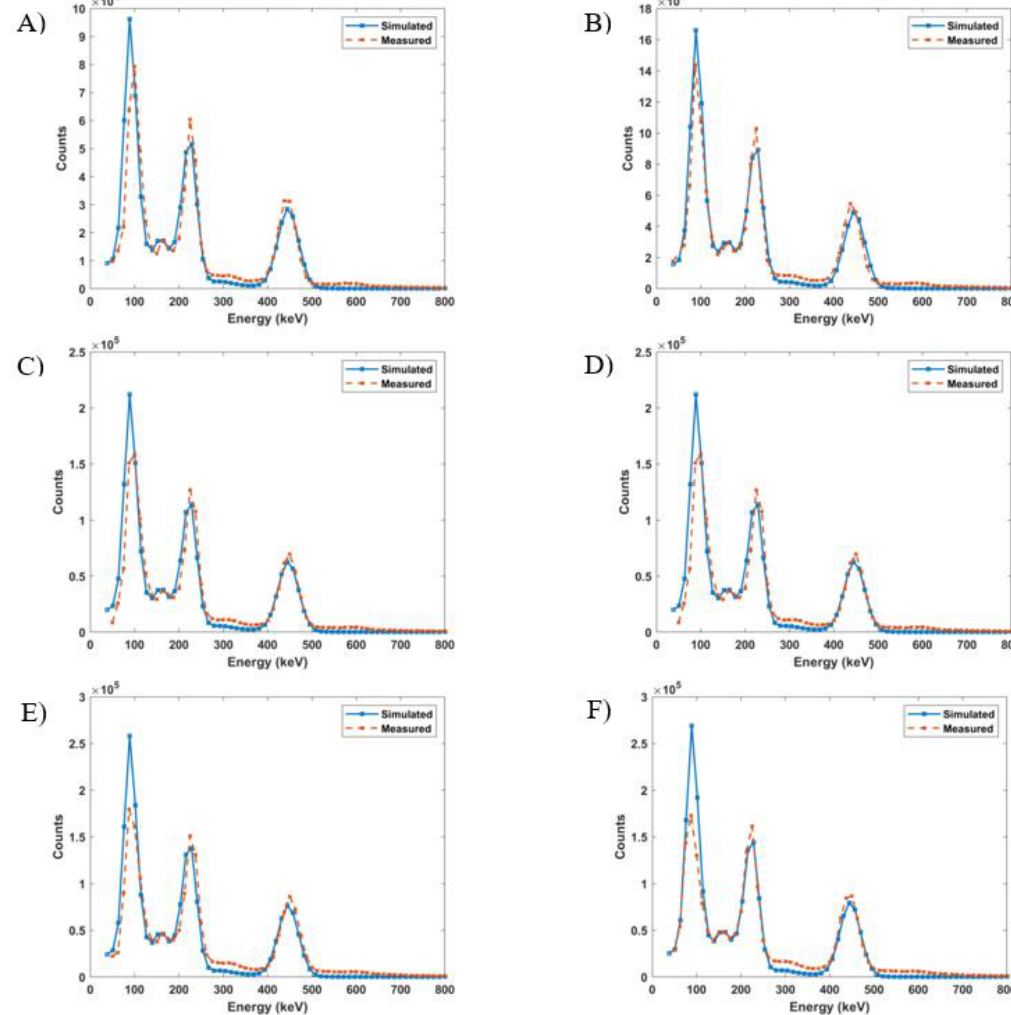
Figure 7. Measured vs. simulated 225 Ac spectra for ( A ) 70.3 kBq (0.17%), ( B ) 144.3 kBq (0.5%), ( C ) 222.0 kBq (0.19%), ( D ) 299.7 kBq (0.99%), ( E ) 370.0 kBq (0.11%), and ( F ) 447.7 kBq (0.02%). The values in parentheses are the mean percent differences between the two spectra.